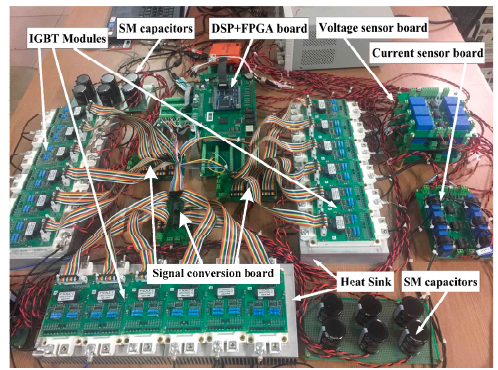
Figure 15. Diagram of the control system .